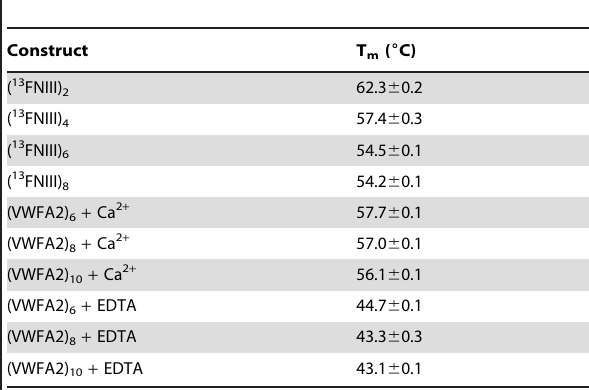
Figure 4. Expression and characterization of 13 FNIII and VWFA2 tandem repeat proteins. Superposed elution profiles from size exclusion chromatography of ( 13 FNIII) 2–8 proteins (A) and (VWFA2) 6–10 (B). (C,D) Coomassie stained SDS-PAGE of the purified proteins. (E,F) Unfolding curves from Thermofluor analysis suggest that the concatameric constructs are properly folded. Note the consistent shift of the (VWFA2) n unfolding curves in the presence and absence of Ca 2 + . Table 2. Apparent melting temperature of concatameric